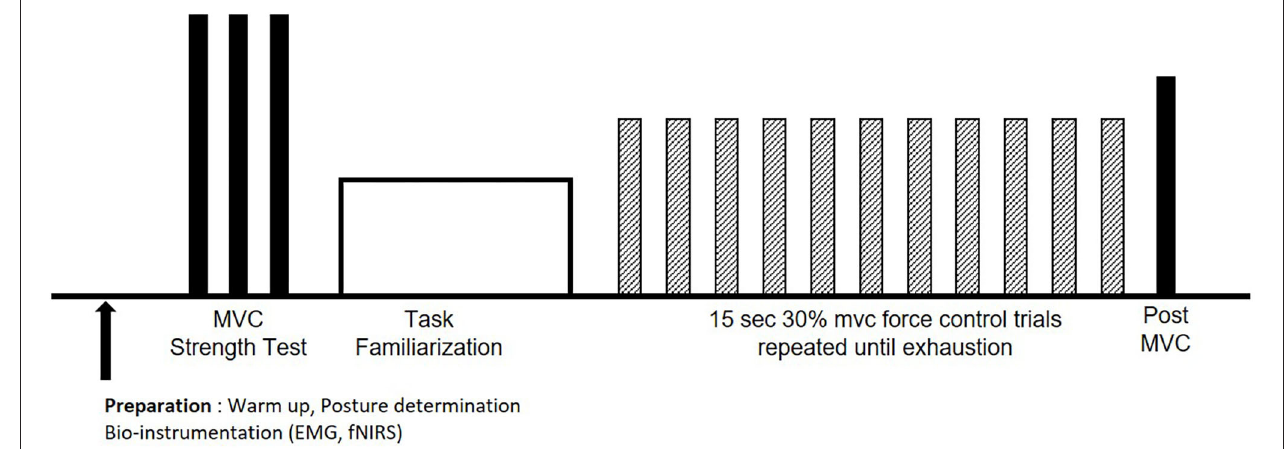
FIGURE 1 | Experimental procedures for each session. After warm up, bioinstrumentation, and posture determination, maximum voluntary contractions (MVCs; solid bars) were performed, followed by task familiarization. Participants performed the endurance test at 30% MVC (hatched bars) until voluntary exhaustion, followed by a post MVC (solid